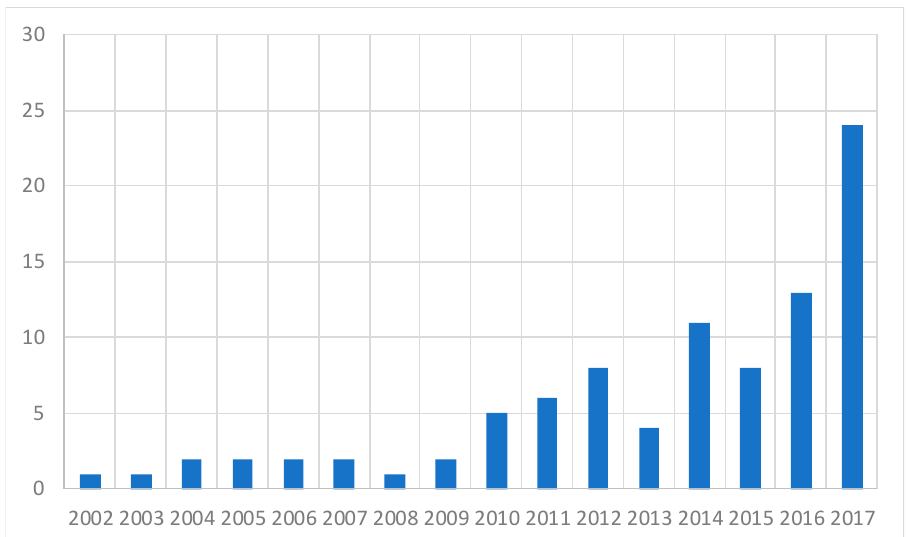
Figure 1. Publication trend on maritime digitalization published per year.